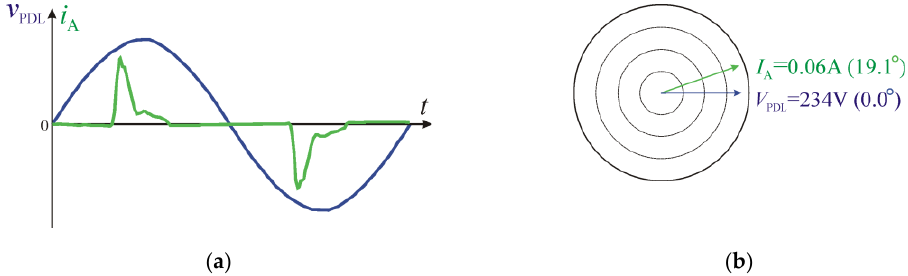
Figure A6. Experimental measurements at the point of connection 1350 lm 3000 K LED light bulb to PDL: ( a ) Voltage and current time diagrams; ( b ) Voltage and current phase diagrams defined for first harmonic.